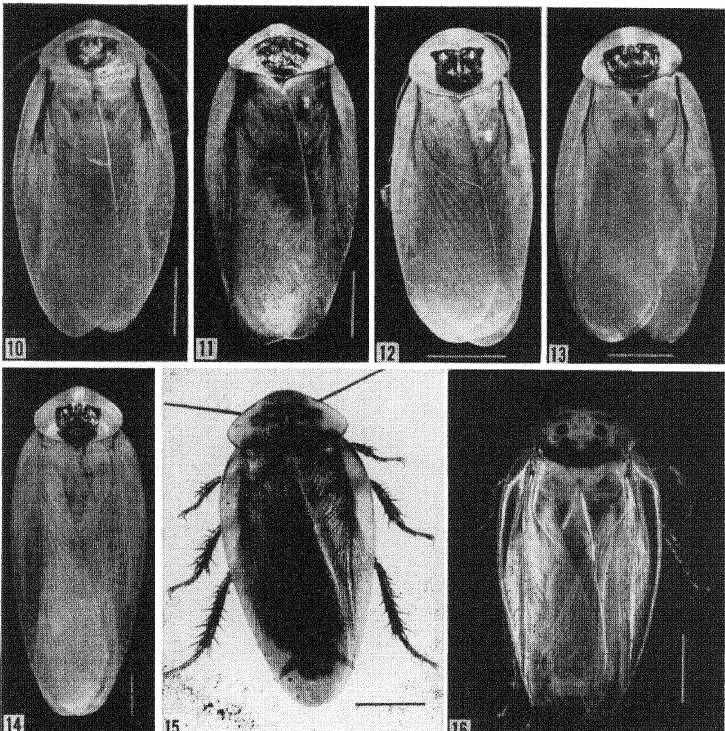
Figs. 10-16. (19 ANSP). Blaberus brasilianus Saussure. Natal, Brazil. 11. (23 ANSP). Blaberus scutatus Saussure (paratype of B. scutata var. obscura S. and Z.). 12. (8 ANSP). Blaberus minor Saussure. Argentina (det. Hebard). 13. (14 ANSP). Blaberus fusiformis Walker. Santa Cruz de la Sierra, Bolivia (det. Hebard). 14. (32 ANSP). Blaberus colosseus (Illiger). Fyzabad, Trinidad (det. Roth). 15. (N). Eublaberus posticus (Eriehson). Panama (det. Roth). 16. (N). Eublaberus distanti (Kirby). Trinidad (det. Roth). (scale 10